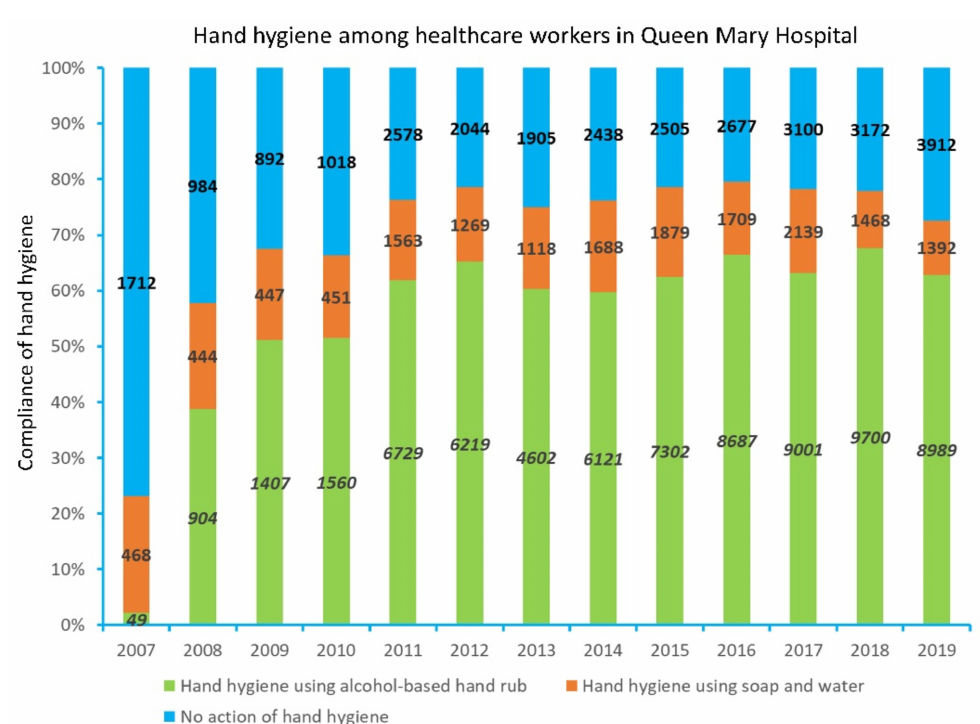
Figure 2. Hand hygiene compliance among healthcare workers in Queen Mary Hospital from 2007 to 2019. The numbers marked in the vertical bars represent the number of observed hand hygiene opportunities by infection control nurses. Non-mediated soap was used throughout the years of study.